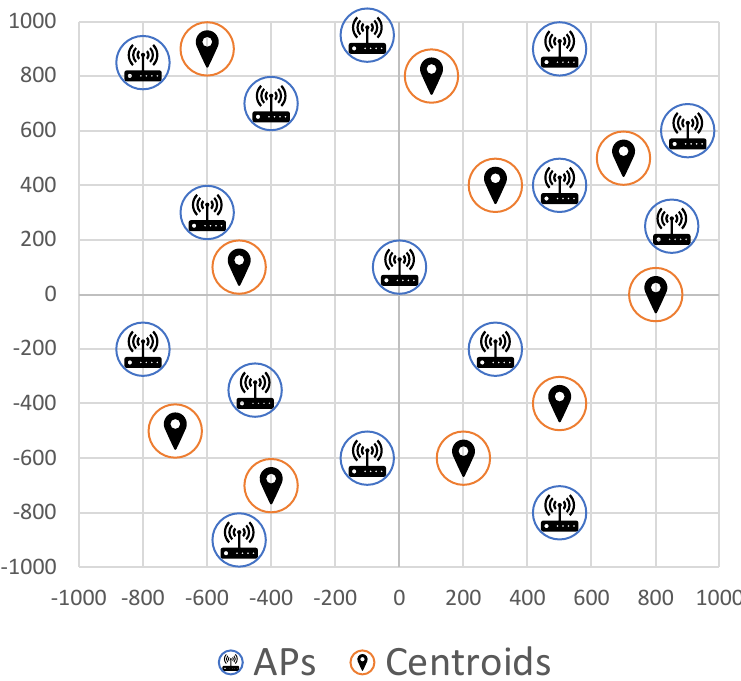
Figure 3. Example of how nodes extend over the predefined area using 15 access points and 10